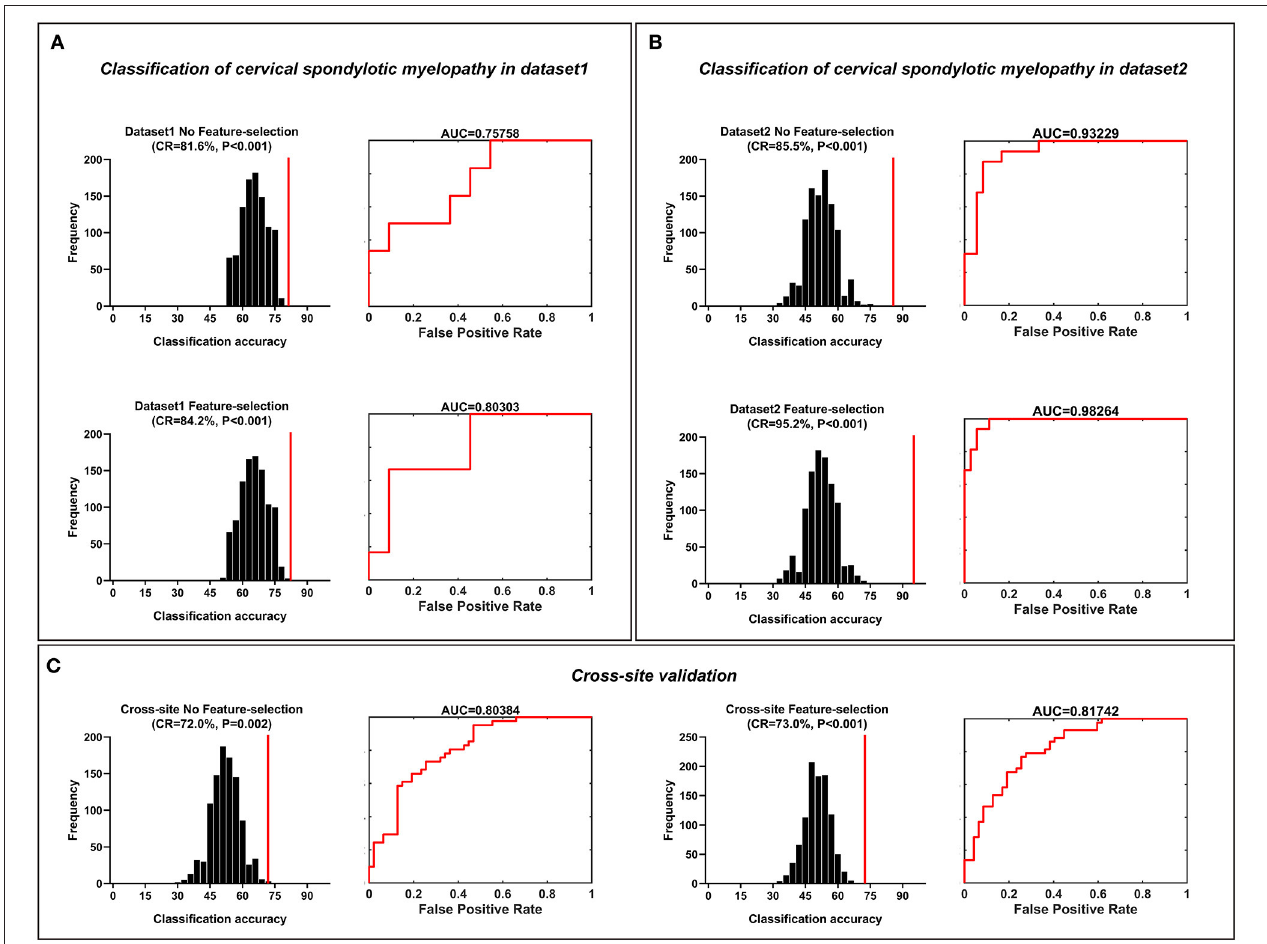
FIGURE 3 | Classification of cervical spondylotic myelopathy patients from healthy controls. Classification of cervical spondylotic myelopathy from healthy adults. (A) The classification accuracies obtained from both feature-selection and no-feature-selection models in dataset 1. (B) The classification accuracies obtained from both the feature-selection model and the no-feature-selection model in dataset 2. (C) The classification accuracies obtained both from both the feature-selection and no-feature-selection models during the cross-site validation procedure. The corresponding ROC curve and AUC were also illustrated. CR, correct rate; ROC, receiver operating characteristic; AUC, area the under